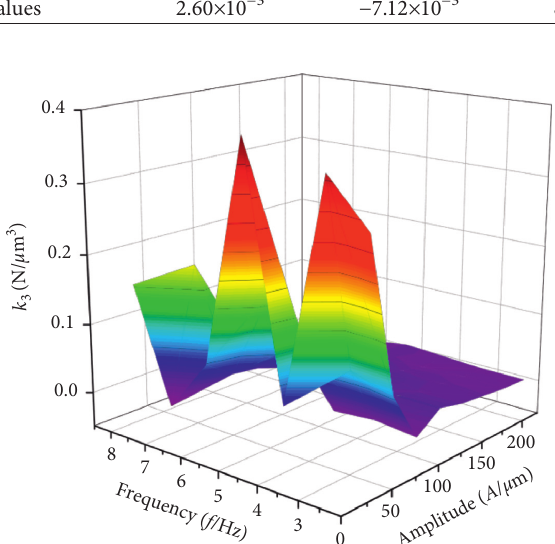
Figure 11: The space surface of nonlinear stiffness coefficient k ( A , f ).